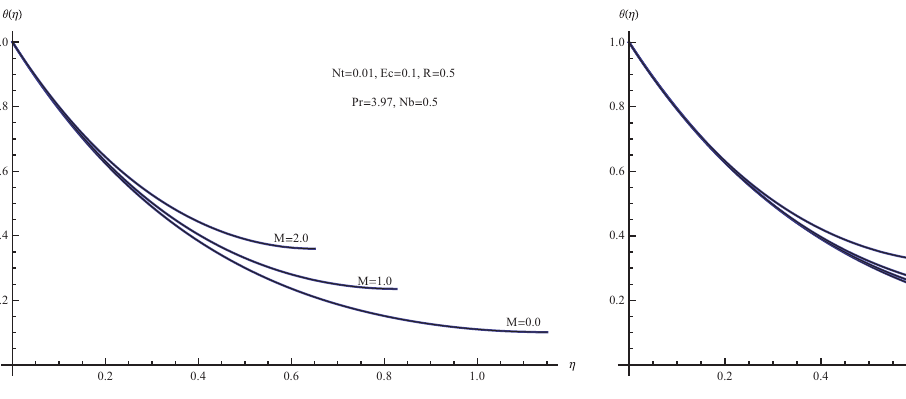
Figure 9: ( ) θ η for assorted quantities of β .